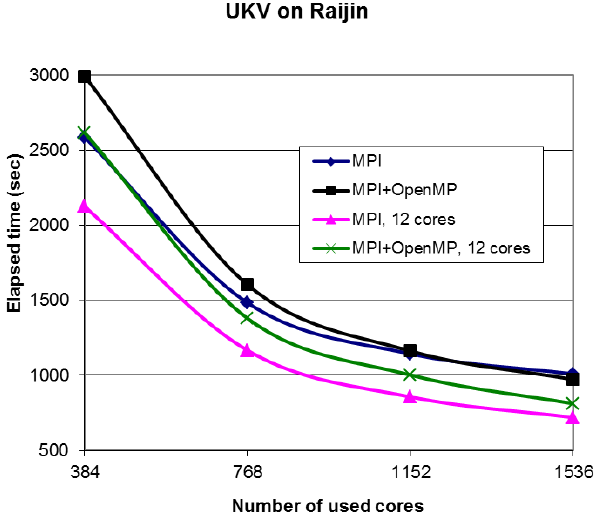
Figure 2. Elapsed times for the UKV model runs on Ngamai versus the number of cores actually used in each